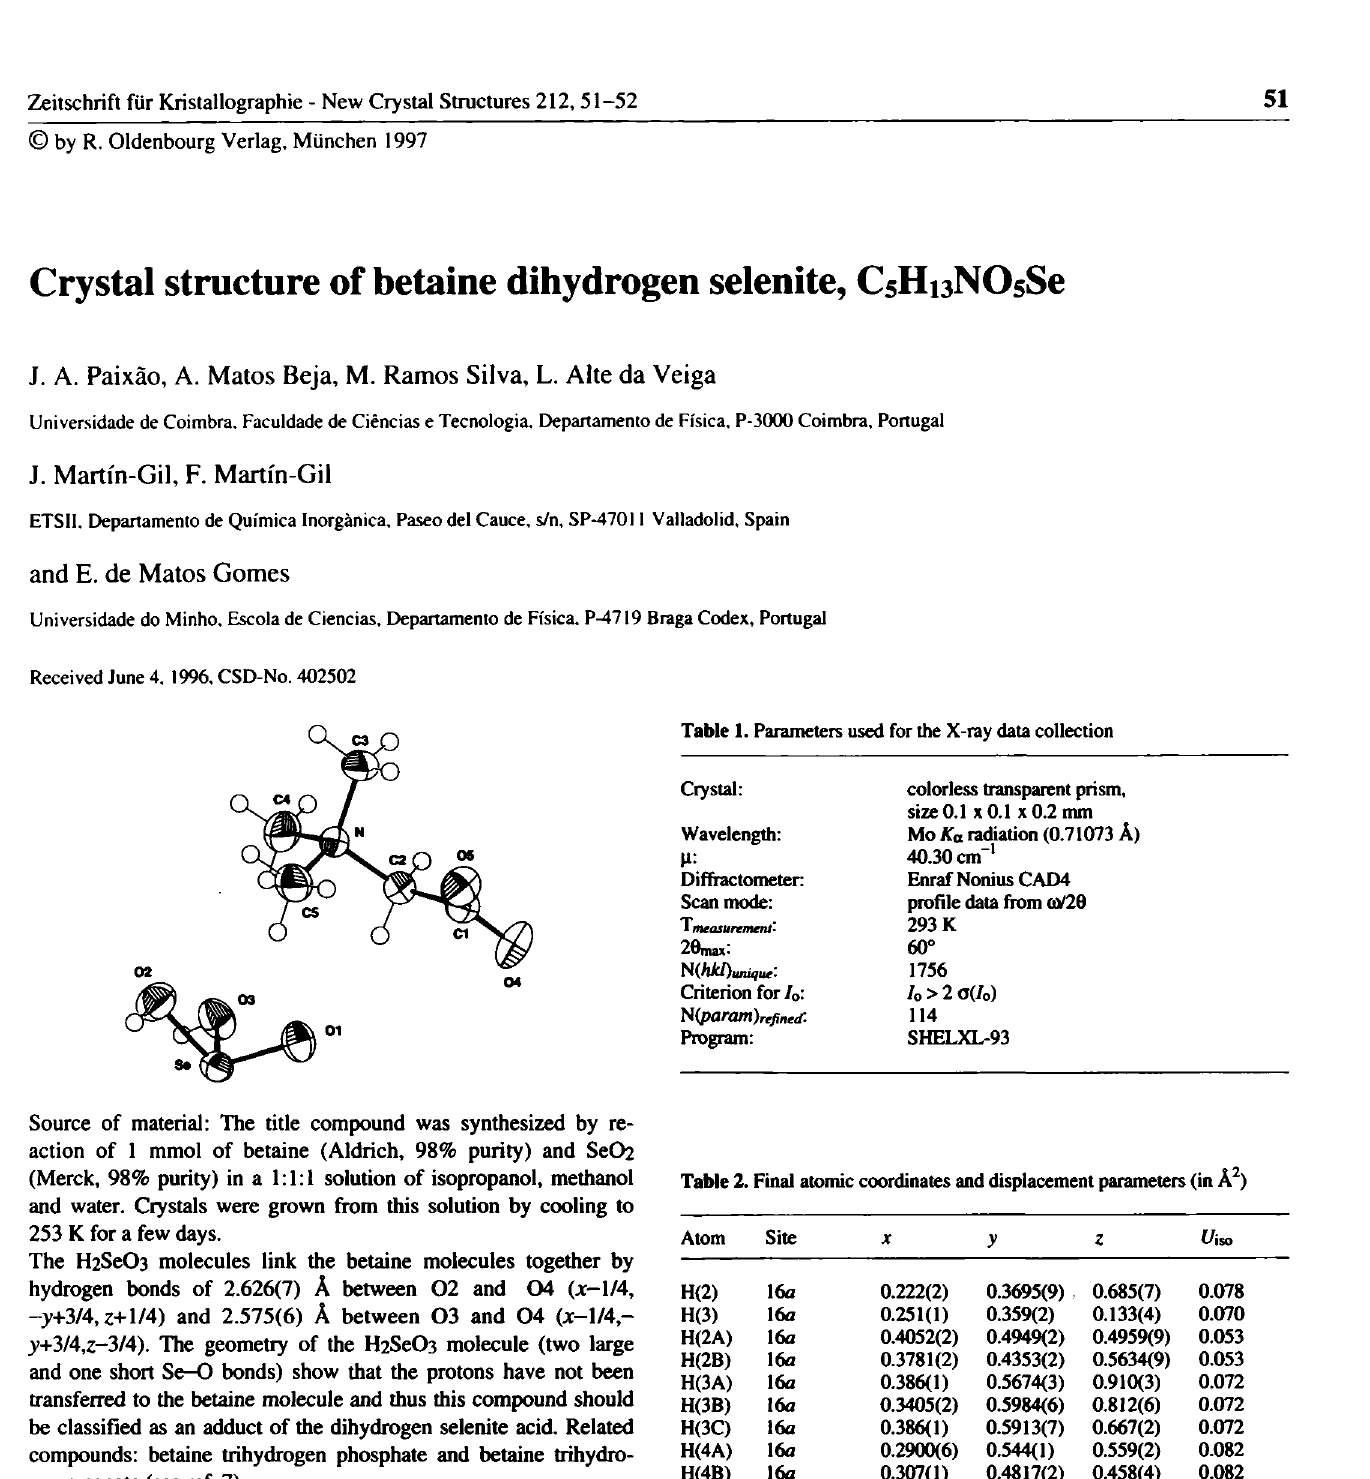
Table 2. Final atomic coordinates and displacement parameters (in Â 2 )